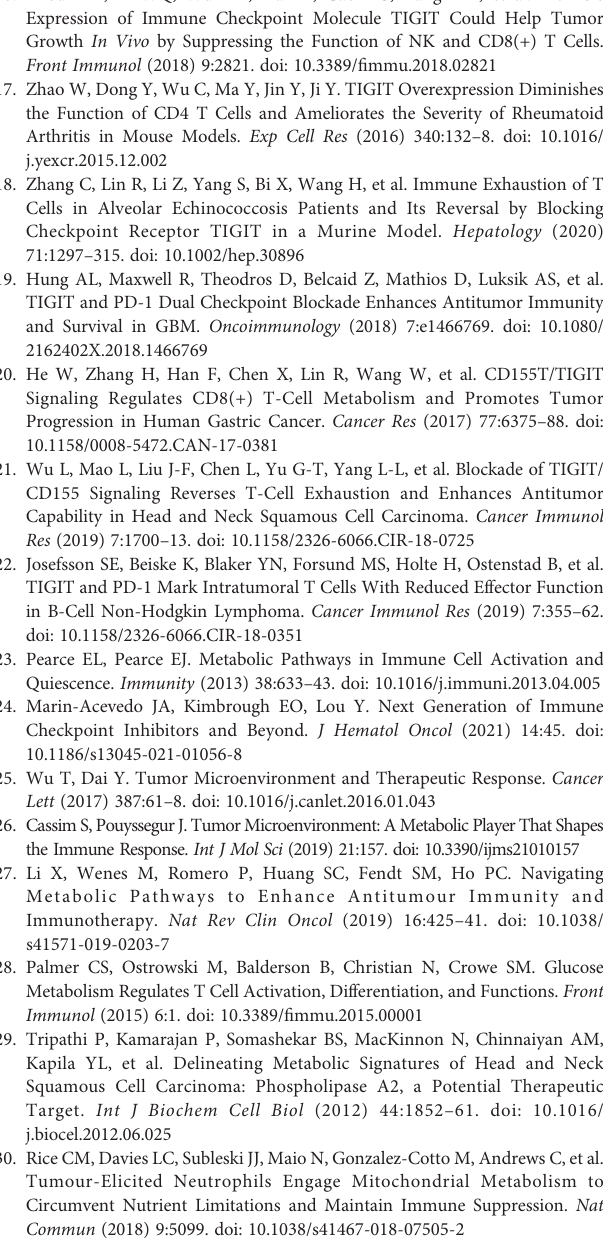
Supplementary Figure 1 | The effect of TIGIT blockade on the glucose metabolic activity of CD3 + TIGIT - T cells. (A) mRNA expression of Glut1, HK1, HK2, and PFK elevated in TIGIT Ab group compared with the control group in CD3 + TIGIT - T cells. (B, C) Western blotting analysis of the phosphorylation levels of the AKT/mTOR pathway in the control group and TIGIT Ab group in CD3 + TIGIT - T